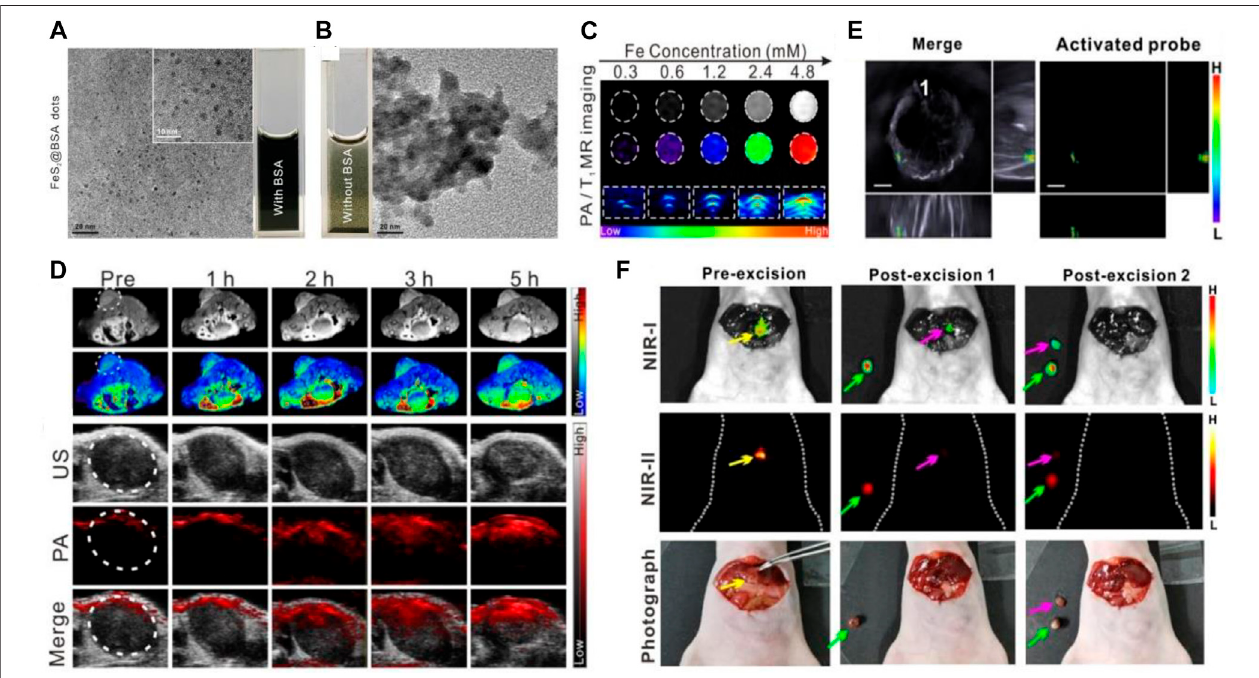
FIGURE 3 | Serum albumin-based nanovehicles as nanoprobes for cancer diagnosis. (A) TEM image of the synthesized FeS@BSA QDs. (B) TEM image of FeS synthesized without BSA. (C) In vitro T 1 -weighted magnetic resonance (MR) images and photoacoustic (PA) images of FeS@BSA QDs at various concentrations. (D) Time-dependent T 1 -weighted MR images, PA, and ultrasound (US) images oftumor before and after i.v.administration ofFeS@BSA QDs. Reproduced with permission from Yanget al.(2020).Copyright2020,Elsevier. (E) The3D MSOTimagesoforthotopic livertumor uponi.v.administration ofBH-NO 2 @BSA. (F) TheNIR-I/NIR-II fl uorescence images and white-light photographs of a mouse with exposed liver and orthotopic liver tumor at the state of pre-excision, post-excision 1, and post- excision 2. The yellow, green, and pink arrows point to the orthotopic liver tumor, the excised tumor, and the excised residual tumor, respectively. Reproduced